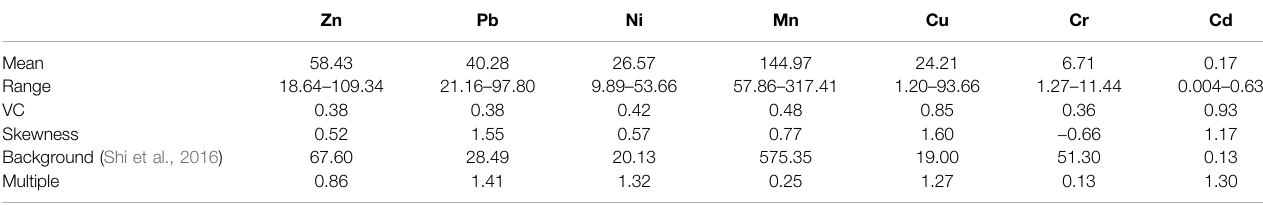
TABLE 2 | The heavy metal consensus-based quality guideline values (mg/kg) and background values (mg/kg) in soils of Jian and Moyang river basins.